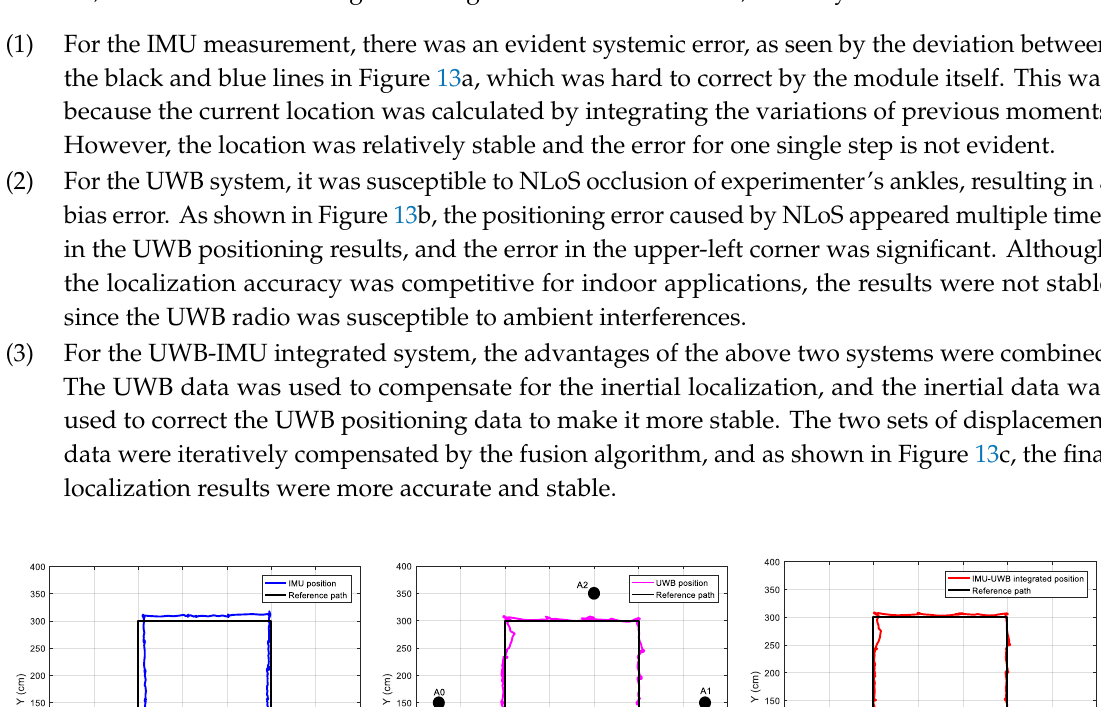
Figure 12. Indoor experimental scene and the experimental setup.